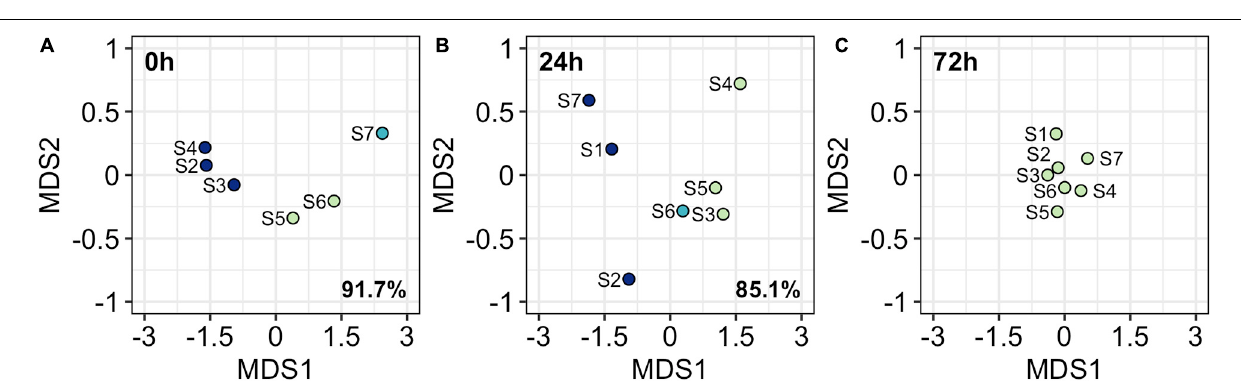
FIGURE 7 | Metric Dimensional Scaling analysis (MDS) ordination plots at 0 h (A) , 24 h (B) , and 72 h (C) . Colors refer to K-mean clustering results. Percentage refers to the BSS/TSS ratio. No BSS/TSS ratio is reported at 72 h since stations are grouped in only one cluster. TABLE 3 | Percentage of total variance for each source of variability: Distance among stations (Space), daily variability (Time), and the inner variability (Within) for Eukaryotes (Euk), Prochlorococcus sp. (Pro), Synechococcus sp. (Syn), and Chlorophyll a (Chl a ). Water column DCM ML Space Time Within Space Time Within Space Time